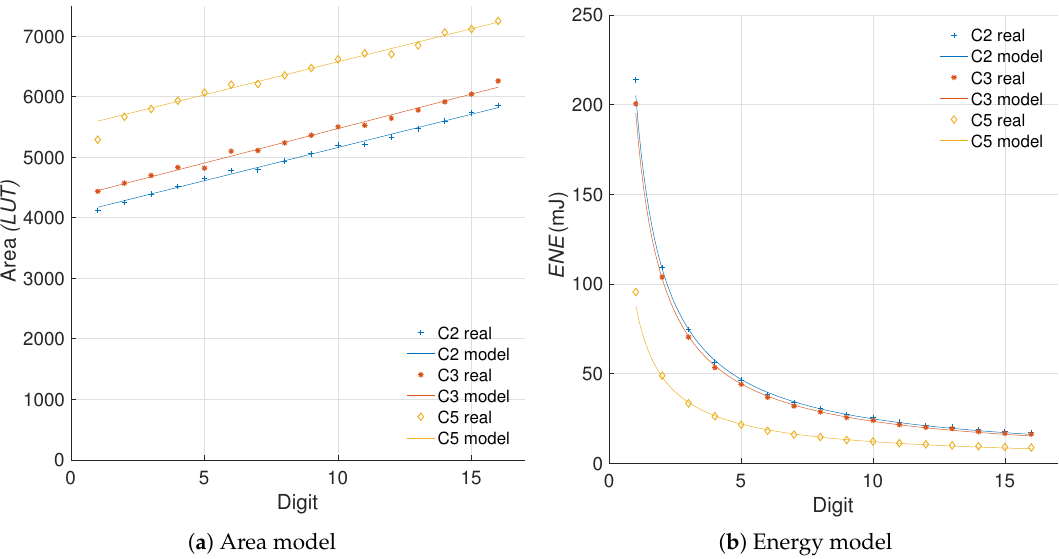
Figure 13. Curve fitting for the hardware usage and energy consumption of architectures C2, C3, and C5.